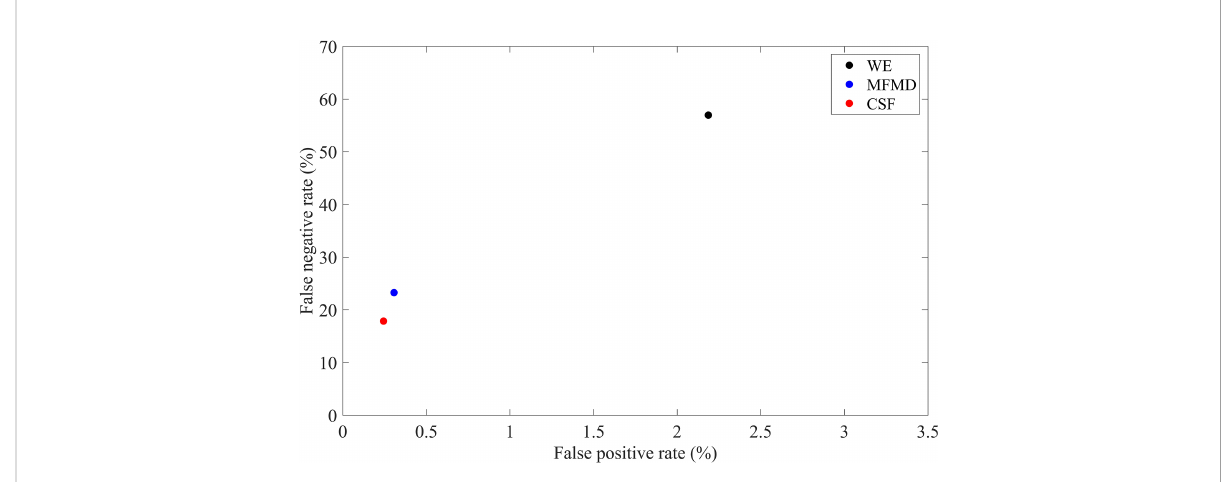
FIGURE 11 The false negative and positive rate of the three methods (the black, blue and red dots represent the method WE, MFMD and CSF